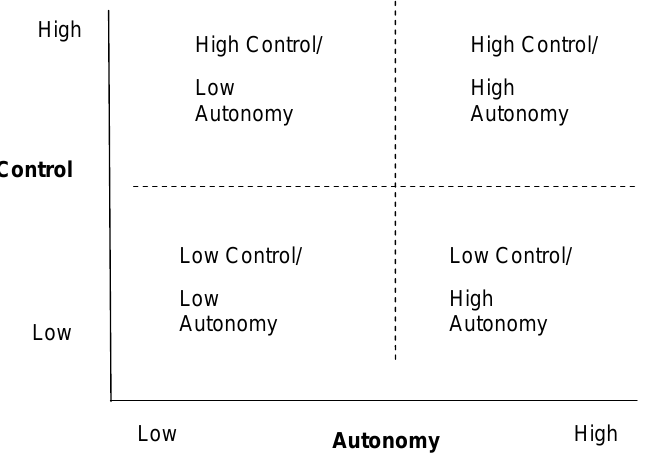
Figure 2: The dynamic management paradox model